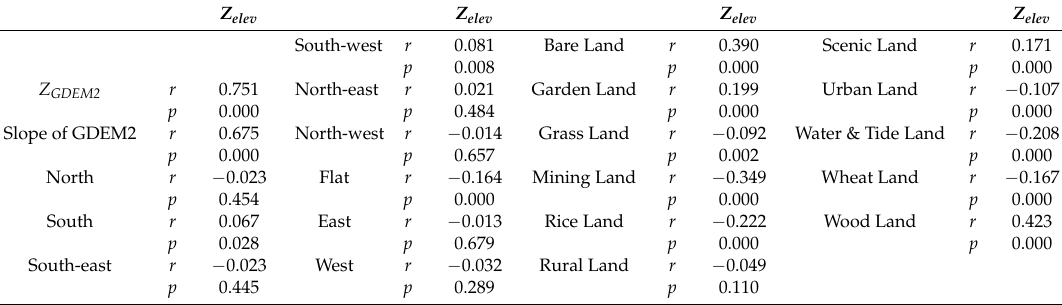
Table 3. The correlation coefficient values (represented by r) and the associated p -values (represented by p ) between the elevation value Z Elev and the independent variables.